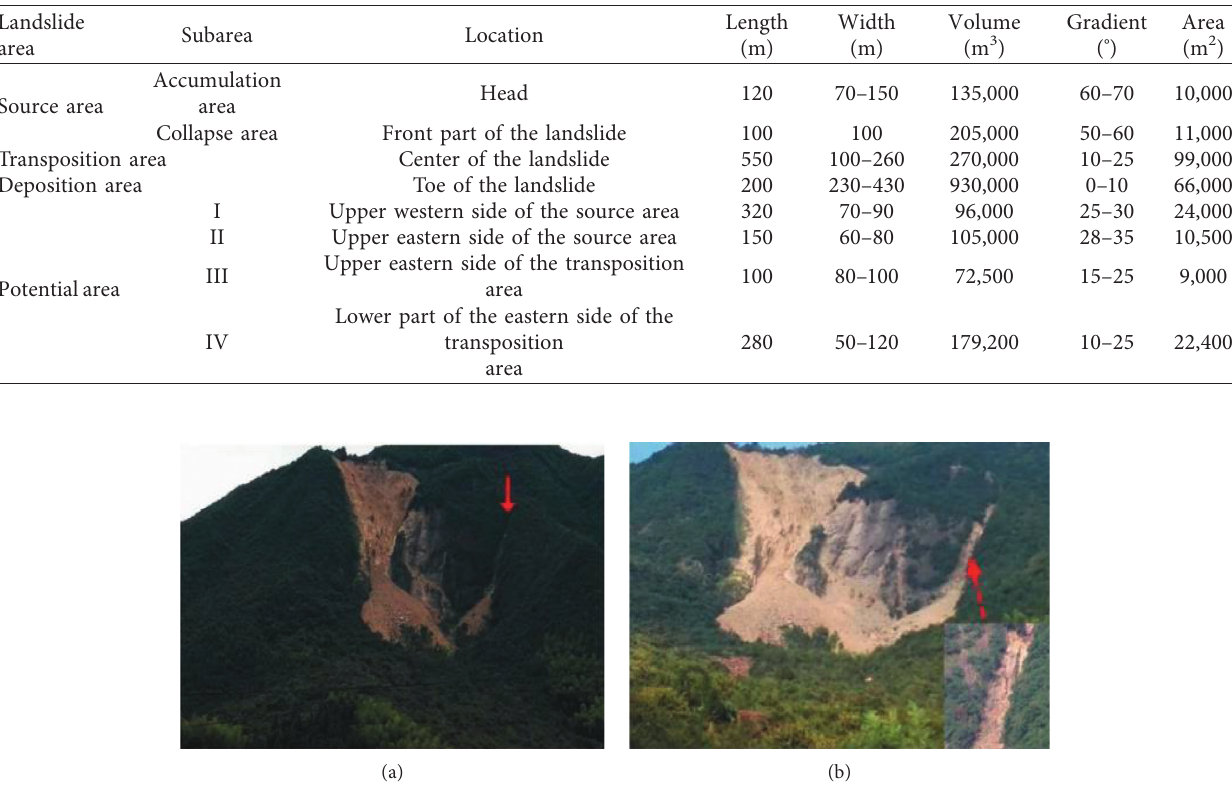
Table 1: The characteristics of different areas of the Sucun rockslide